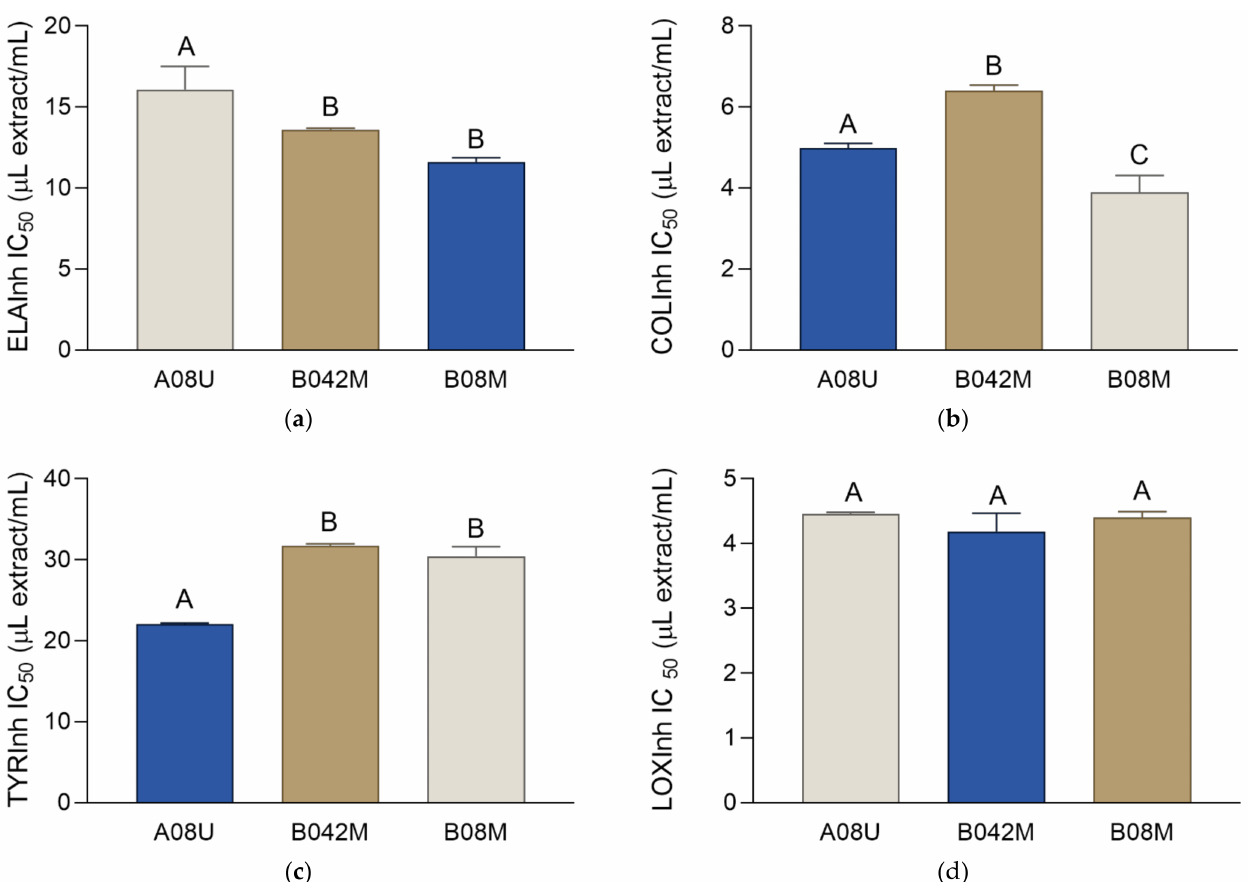
Figure 5. Inhibitory activity of the extracts (A08U, B042M, B08M) on the enzymes that accelerate skin aging: ( a ) elastase (ELAInh), ( b ) collagenase (COLInh), ( c ) tyrosinase (TYRInh), and ( d ) lipoxyge- nase (LOXInh). The activities are shown as IC 50 values ± SD. Different uppercase letters indicate statistically significant differences ( p <